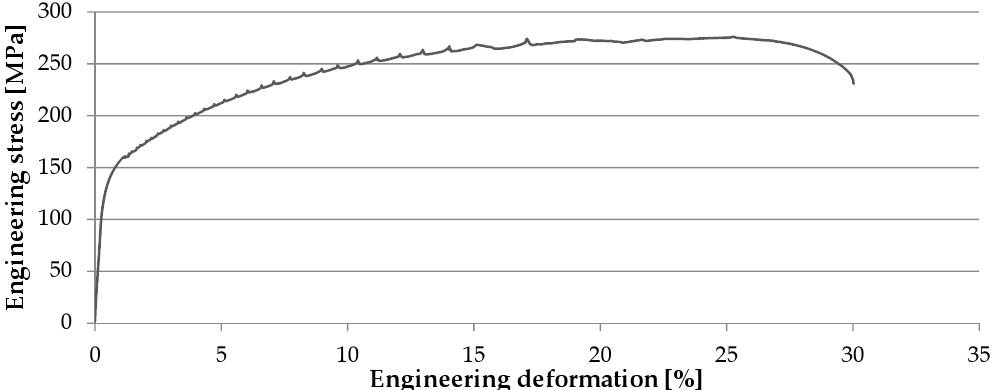
Figure 19. Example of tensile test sample extracted in horizontal direction and manufactured with Argon 30 L/min + cir-